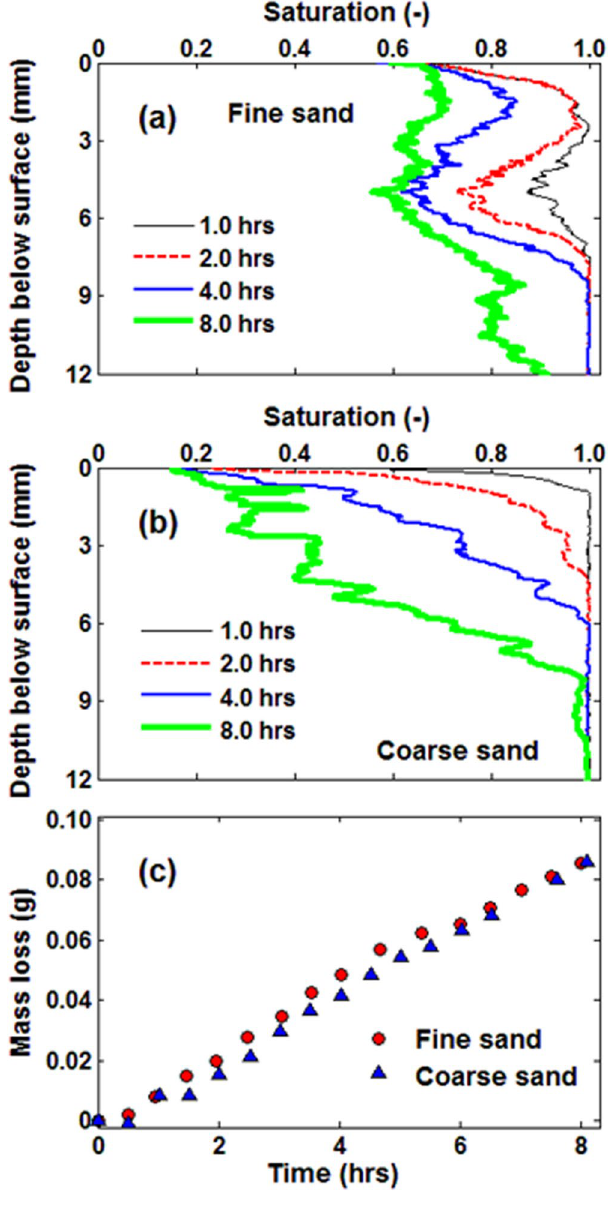
Figure 2. Time-dependence of the liquid saturation profiles, from the onset of the experiment (indicated in the legend) during evaporation from ( a ) fine- and ( b ) coarse-grained sands. ( c ) The computed cumulative mass losses over time during evaporation, computed using the segmented images obtained by synchrotron X-ray